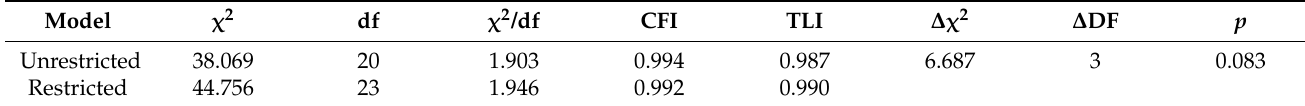
Table 5. Multi-group SEM fitting